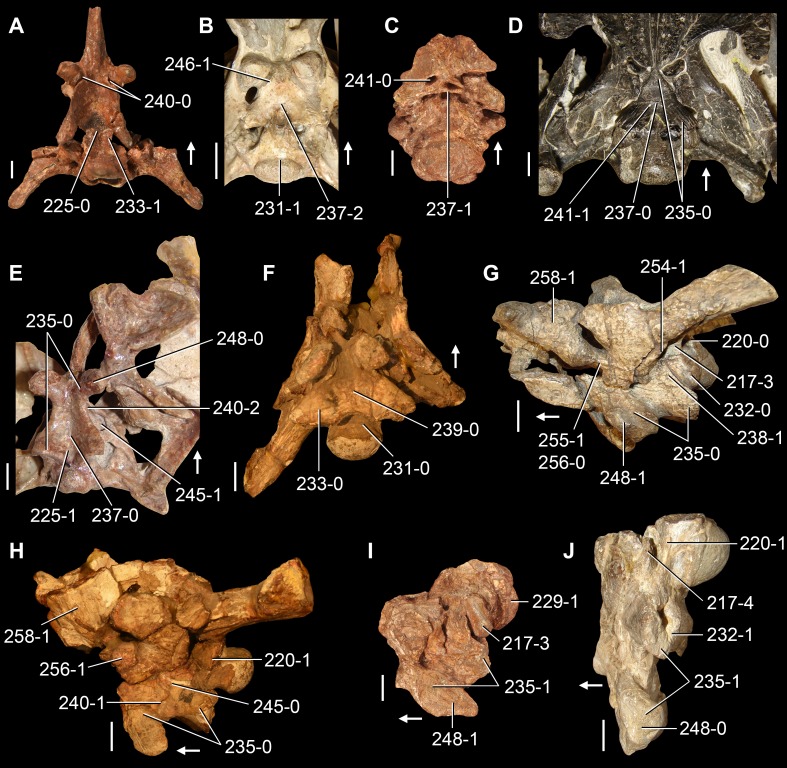
Braincases of Triassic archosauromorphs in (A–F) ventral and (G–J) lateral views.(A) Prolacerta broomi (BP/1/2675); (B) Proterosuchus alexanderi (NMQR 1484); (C, I) Garjainia madiba (BP/1/5525); (D) Doswellia kaltenbachi (USNM 214823); (E) Lewisuchus admixtus (PULR 01); (F, H) Parasuchus hislopi (ISI R42, mirrored); (G) Proterosuchus goweri (NMQR 880); and (J) Batrachotomus kupferzellensis (SMNS 80260). Numbers indicate character-states scored in the data matrix and the arrows indicate anterior direction. Scale bars equal 2 mm in (A), 1 cm in (B, C, F–J), and 5 mm in (D, E).